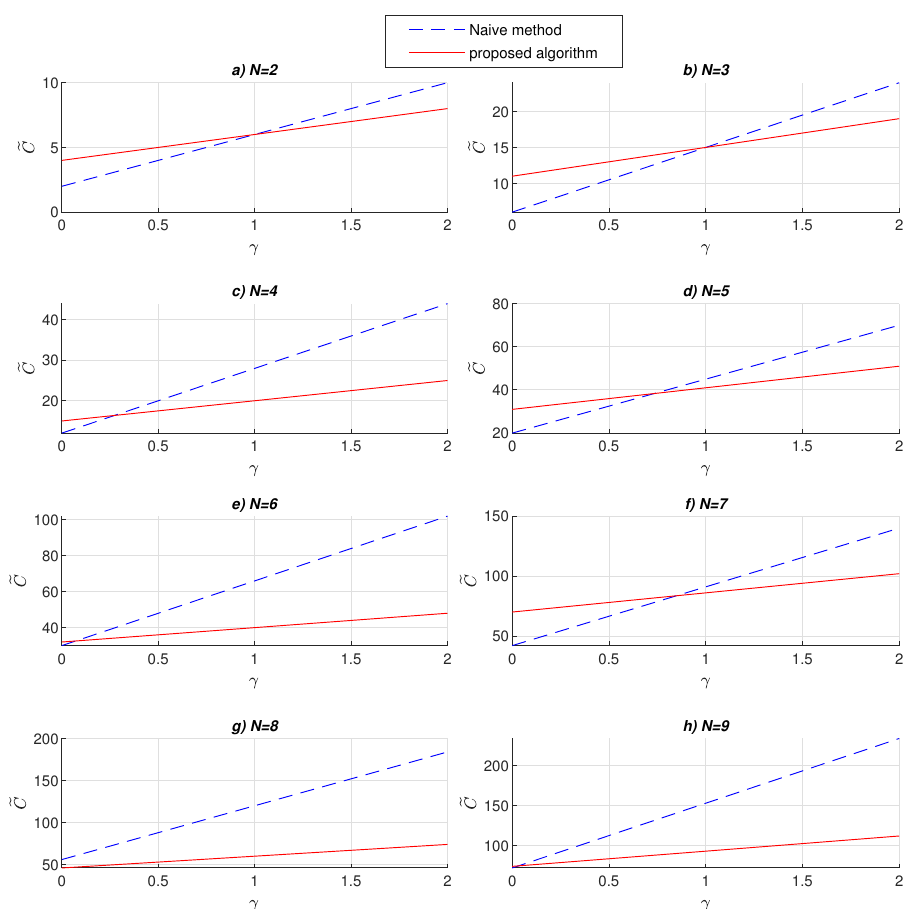
Figure 9. The normalized hardware implementation costs (cid:101) C of the proposed solution and naive method, as a function of the relative cost coefficient γ of the multiplier, for various N .